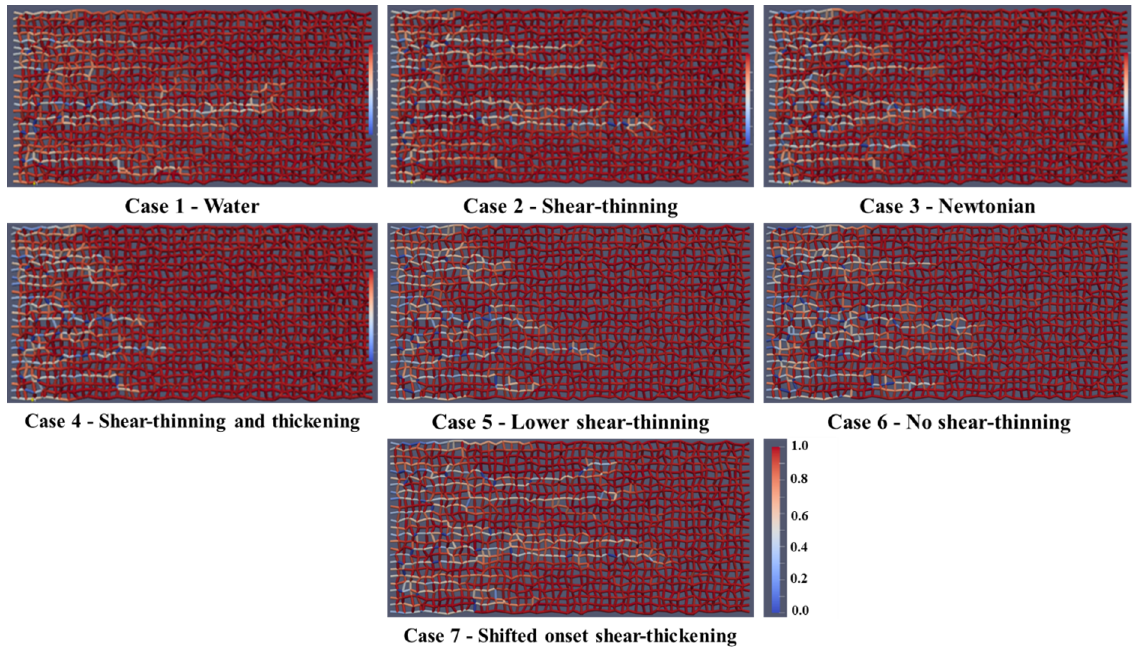
Figure 7. Fluid distribution (oil and water) after 0.1 PV of injected fluid.